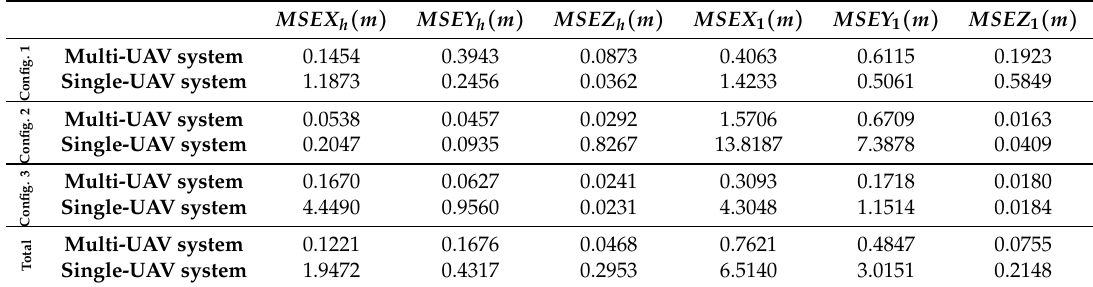
Table 4. Mean Squared Error for the estimated position of the lead agent ( MSEX h , MSEY h , MSEZ h ) and the estimated position of Quad 1 ( MSEX 1 , MSEY 1 , MSEZ 1 ).